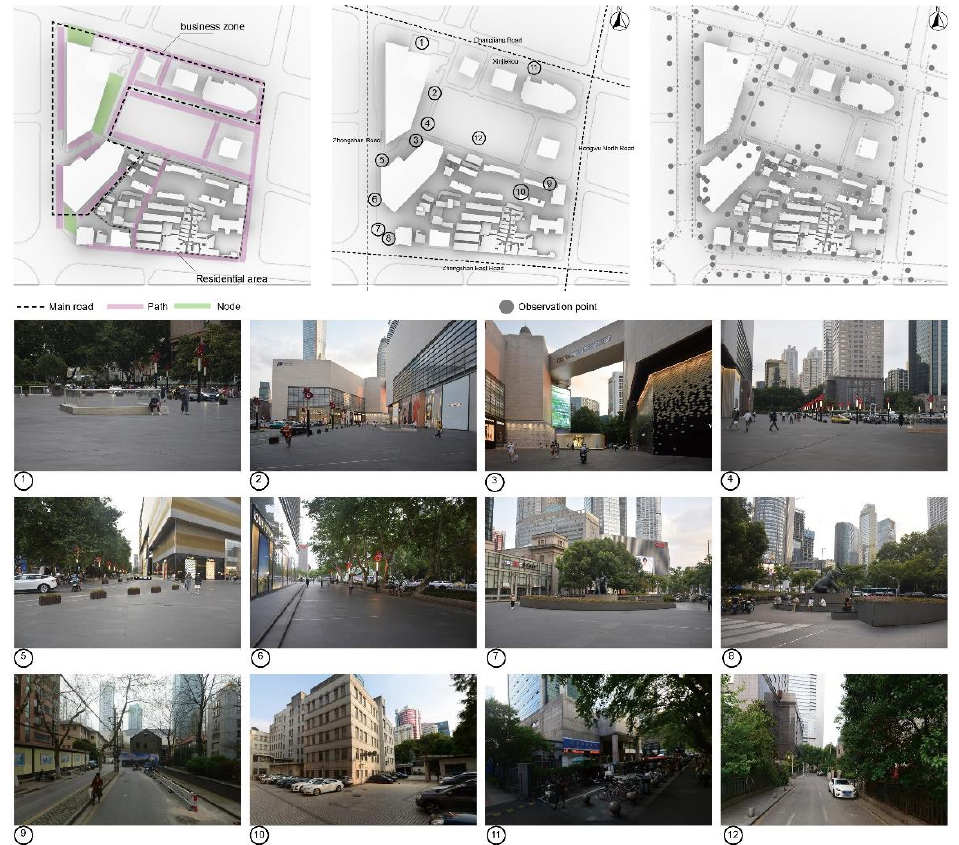
Figure 5. Top left, the distribution of public space types in the site with the distribution of building functions. Upper middle, index of actual photos of the site. Upper right, location of observation points for recording the number of public participants. Bottom, actual photos of the site.